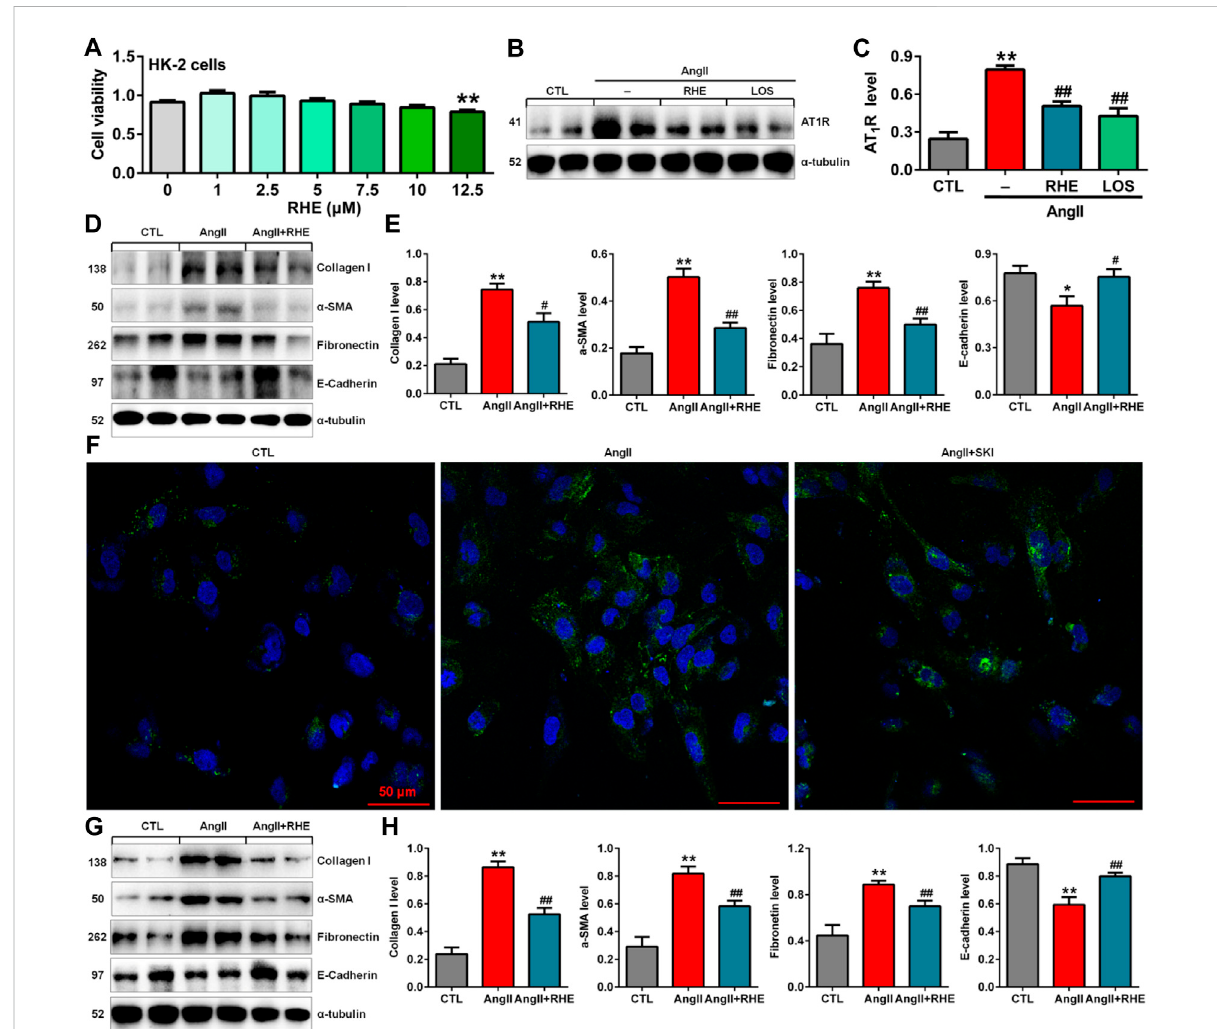
FIGURE 6 Rhein inhibited EMT by blocking the RAS in AngII-induced HK-2 cells. (A) Cell viability analysis after HK-2 cells were treated with increasing concentrations of rhein (0 – 12.5 μ M). (B) Protein expression of AT 1 R in AngII-induced HK-2 cells treated with rhein and losartan. (C) Quantitative analysis of the protein expression of AT 1 R in AngII-induced HK-2 cells treated with rhein and losartan. (D) Protein expression of collagen I, α -SMA, E-cadherin and fi bronectin in AngII-induced HK-2 cells treated with rhein. (E) Quantitative analysis of the protein expression of collagen I, α - SMA, E-cadherin and fi bronectin in AngII-induced NRK-49F cells treated with rhein. (F) Representative immuno fl uorescent analysis of fi bronectin in AngII-induced HK-2 cells treated with SKI. (G) Protein expression of collagen I, α -SMA, E-cadherin and fi bronectin in AngII-induced NRK-49F cells treated with rhein. (H) Quantitative analysis of the protein expression of collagen I, α -SMA, E-cadherin and fi bronectin in AngII-induced NRK-49F cells treated with rhein. * p < 0.05, ** p < 0.01 compared with the control group; # p < 0.05, ## p < 0.01 compared with the AngII-induced